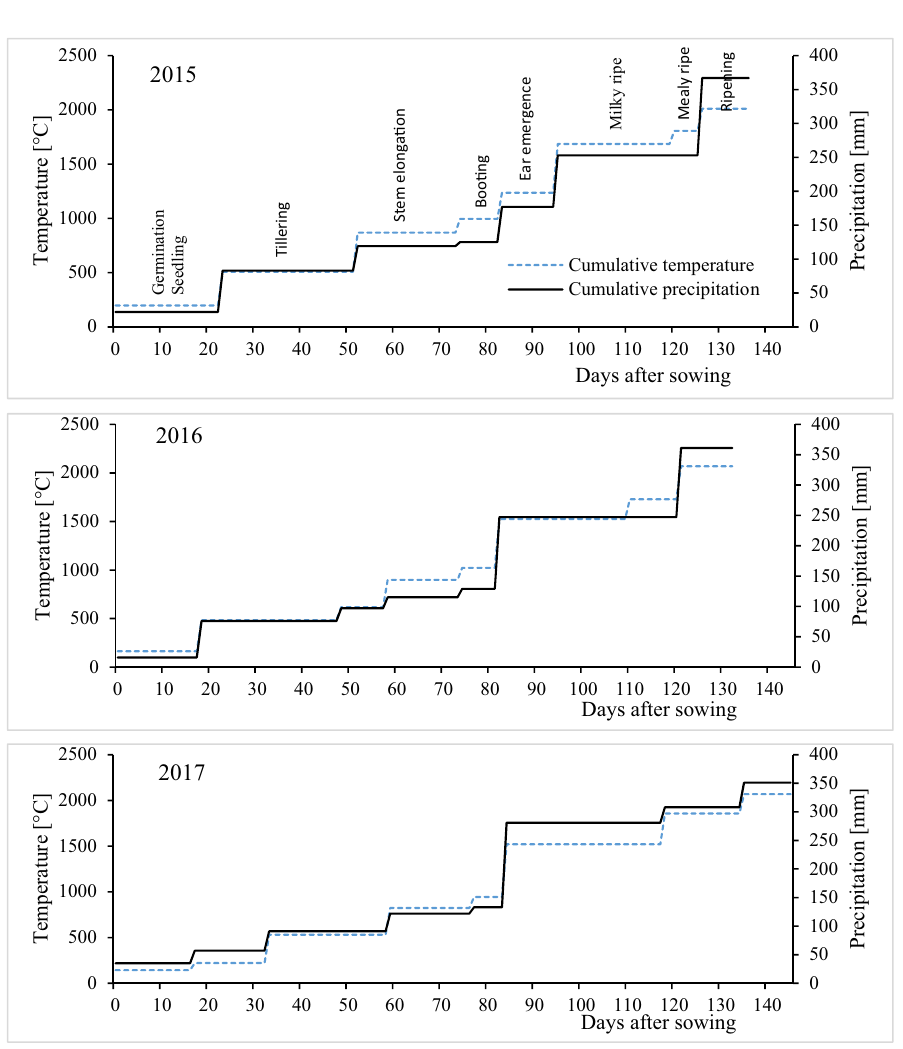
Figure 1. Cumulative temperatures and precipitation in the phenological phases of T. durum in